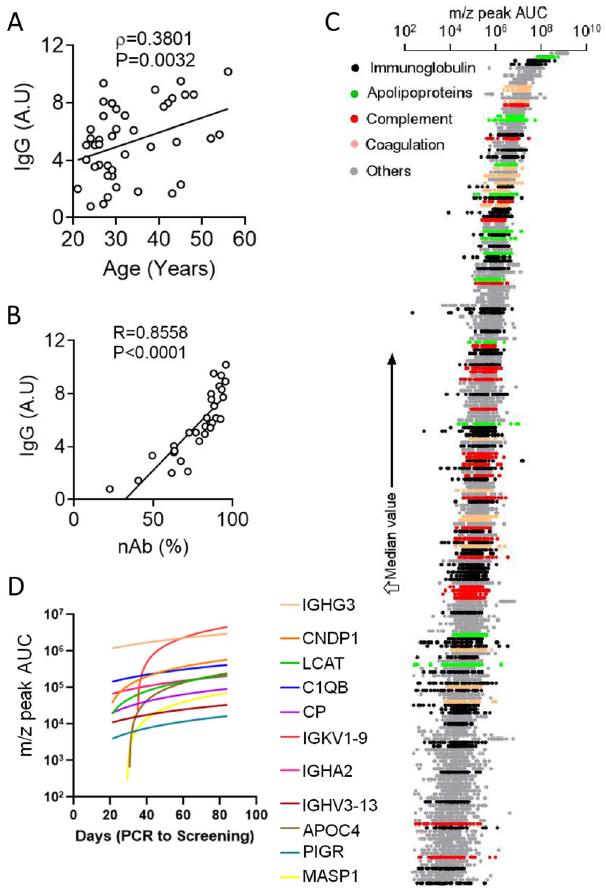
Fig. 1 Convalescent donor characteristics. A Correlation between the anti- SARS-CoV-2 spike IgG content of CP and age of donors. B Correlation between the anti-spike IgG content of CP and the ef fi ciency to neutralize spike protein RBD-ACE2 interaction. C A scatter plot showing the relative abundance of the constituents of CP proteome with colour coding for major functional families. D Statistically signi fi cant correlation (Pearson correlation, p -value < 0.05, one tailed) of CP constituents with the time since RT-PCR positivity of the donors. Spearmann or Pearson correlation was computed and the corresponding ρ or R and two-tailed P -values are noted when signi fi cant correlation is